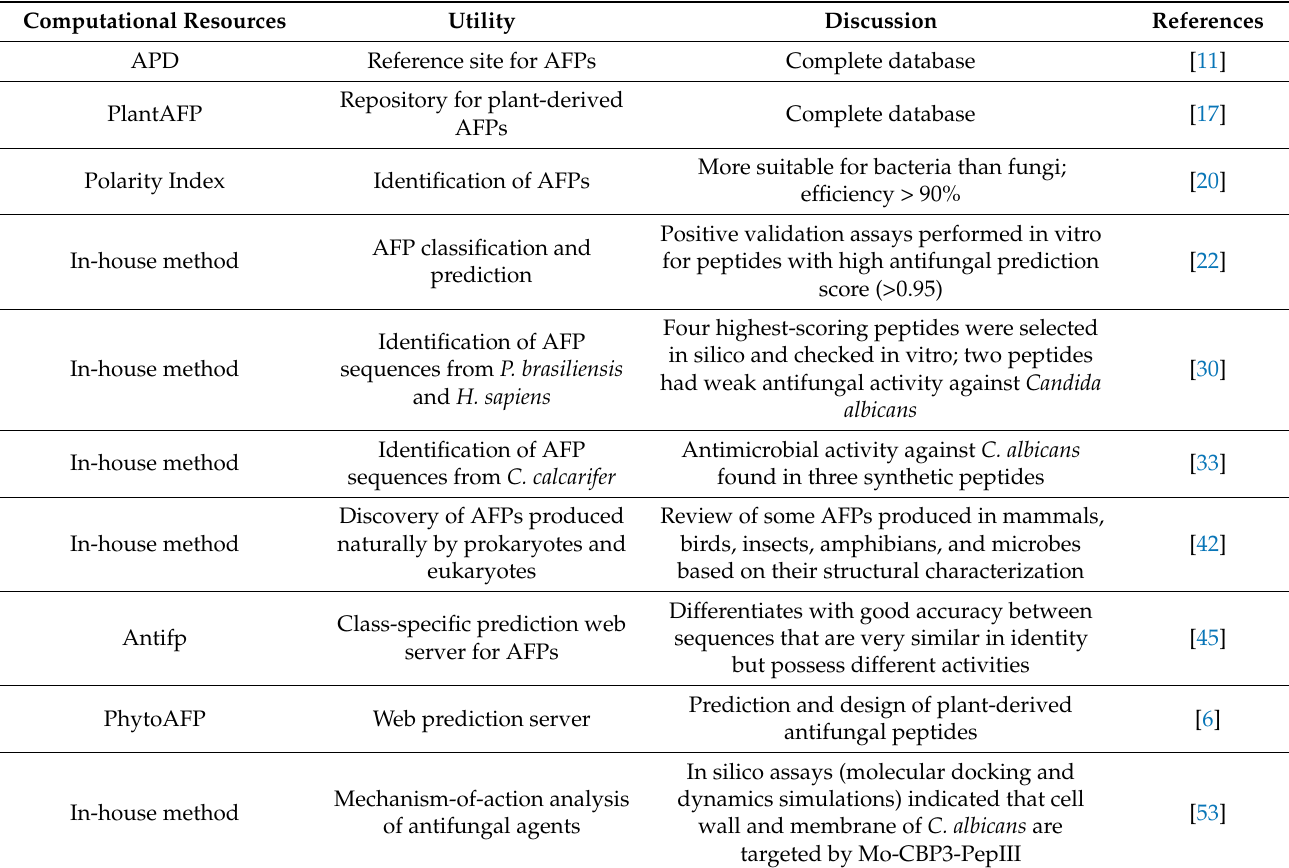
Table 1. Computer tools applied to the identification, discovery, or molecular dynamics of antifungal peptides